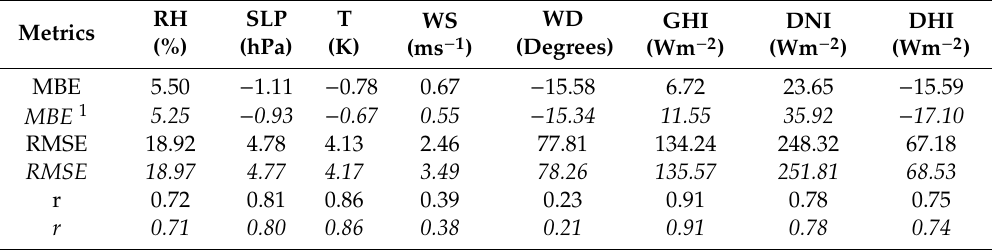
Table 4. Evaluation metrics for long-term simulations.